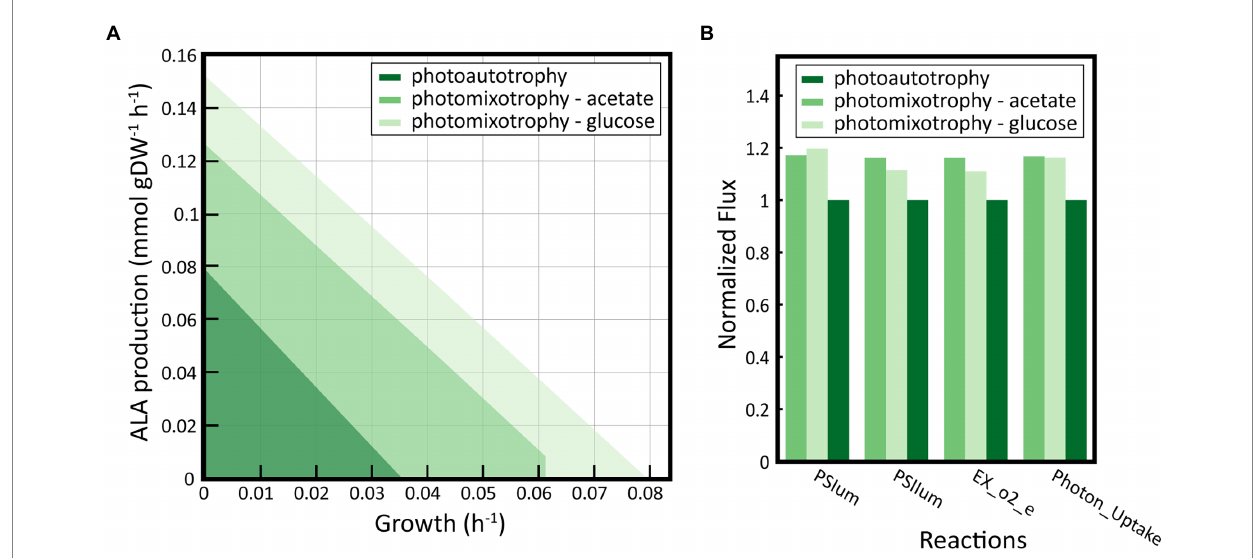
FIGURE 7 Exploration of the metabolic space under photomixotrophic conditions. (A) ALA production envelopes in photoautotrophic and photomixotrophic conditions using acetate or glucose as carbon source. The solution space increases under photomixotrophic conditions. (B) Evaluation of photosynthetic activity under photoautotrophic and photomixotrophic conditions. The flux of the reactions associated with the activity of Photosystem I and II (PSIum and PSIIum, respectively), the production of oxygen (EX_o2_e) and the flux oh photons (Photon_uptake) under photomixotrophic were simulated and normalized to the values obtained under photoautotrophic conditions.